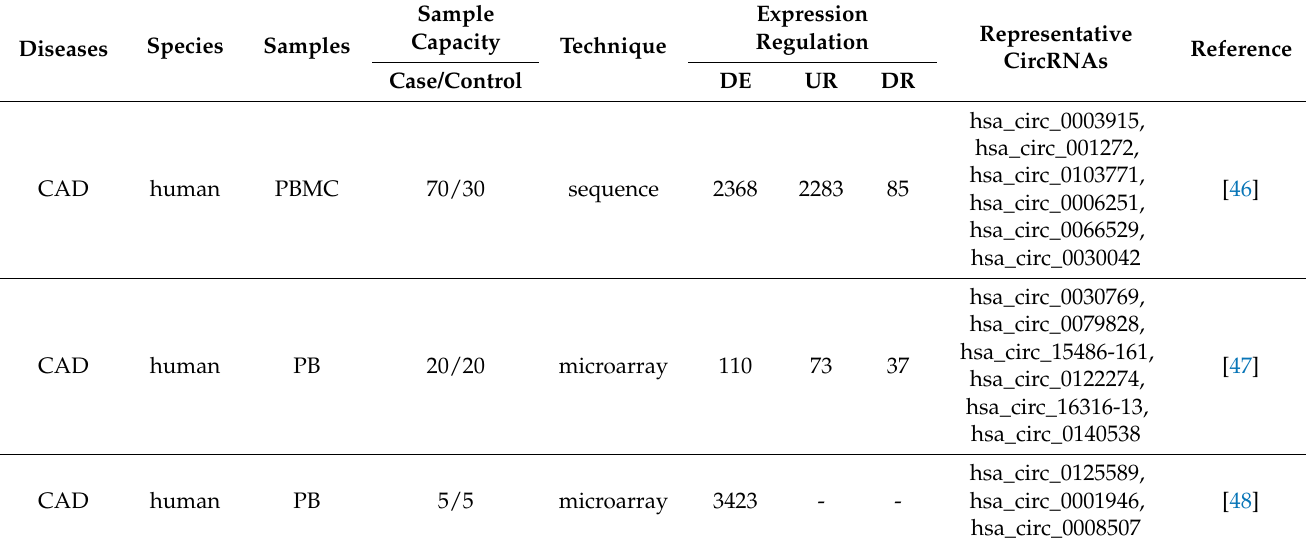
Table 1. Different expressions of circRNAs in sudden cardiac death (SCD) related diseases by RNA sequencing or microar- ray